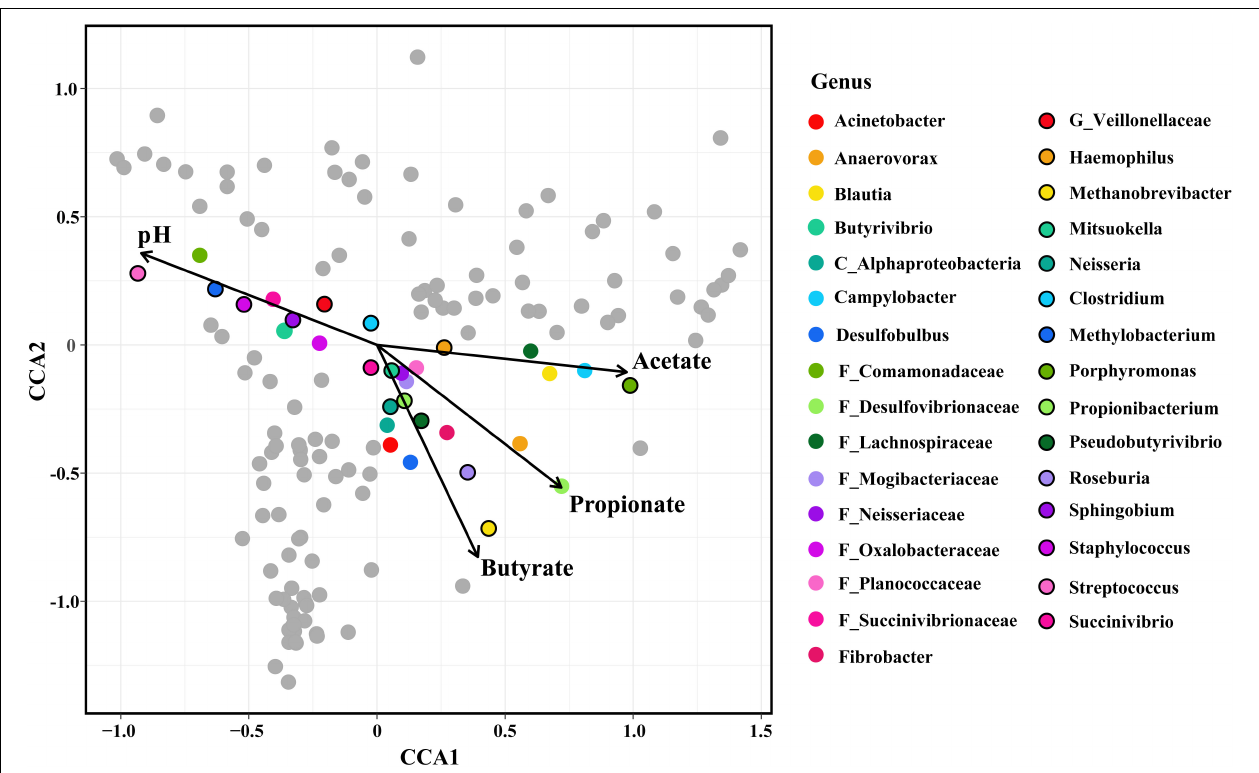
FIGURE 2 | Constrained correspondence analysis (CCA) revealing the correlations between the abundance of the microbial genera and the concentrations of ruminal SCFAs/the value of ruminal pH. The genera, whose relative abundance was highly related to the SCFAs concentration/ruminal pH in the CCA, were colored. The length of the arrow indicated the importance of SCFAs/pH in the shaping of the epimural microbiota, and the vertical distance of the special genera to the arrow indicated the correlation between SCFAs concentrations/pH and the relative abundance of microbial